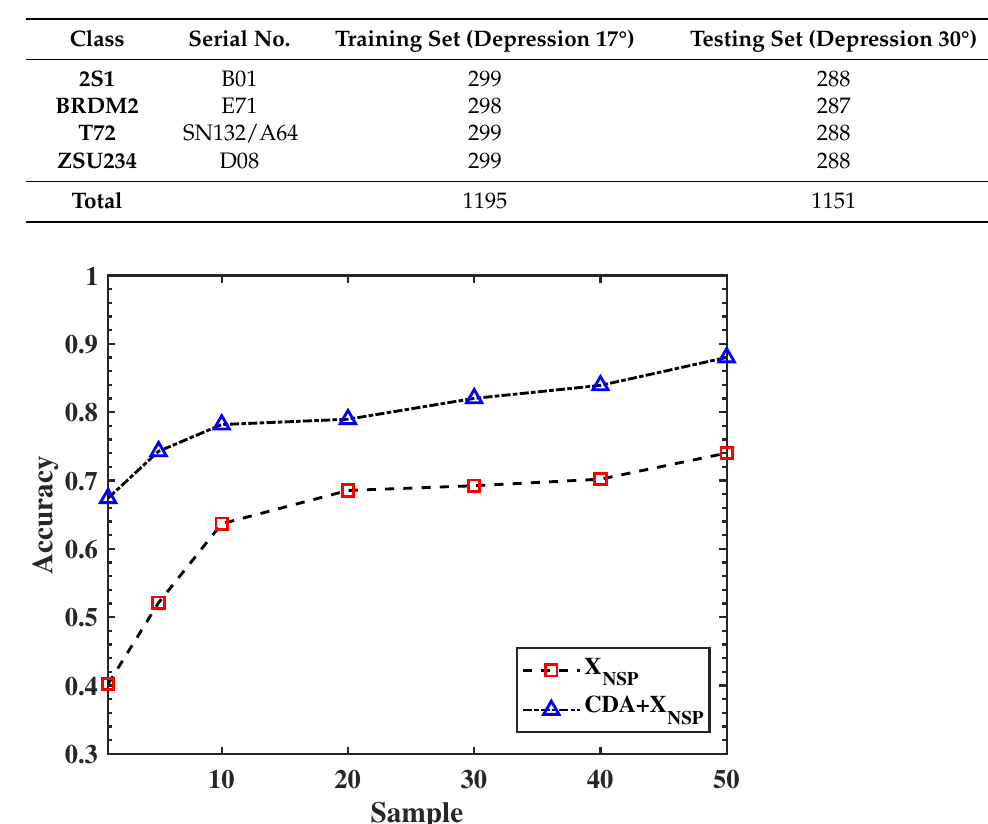
Table 4. Data description for EOC.